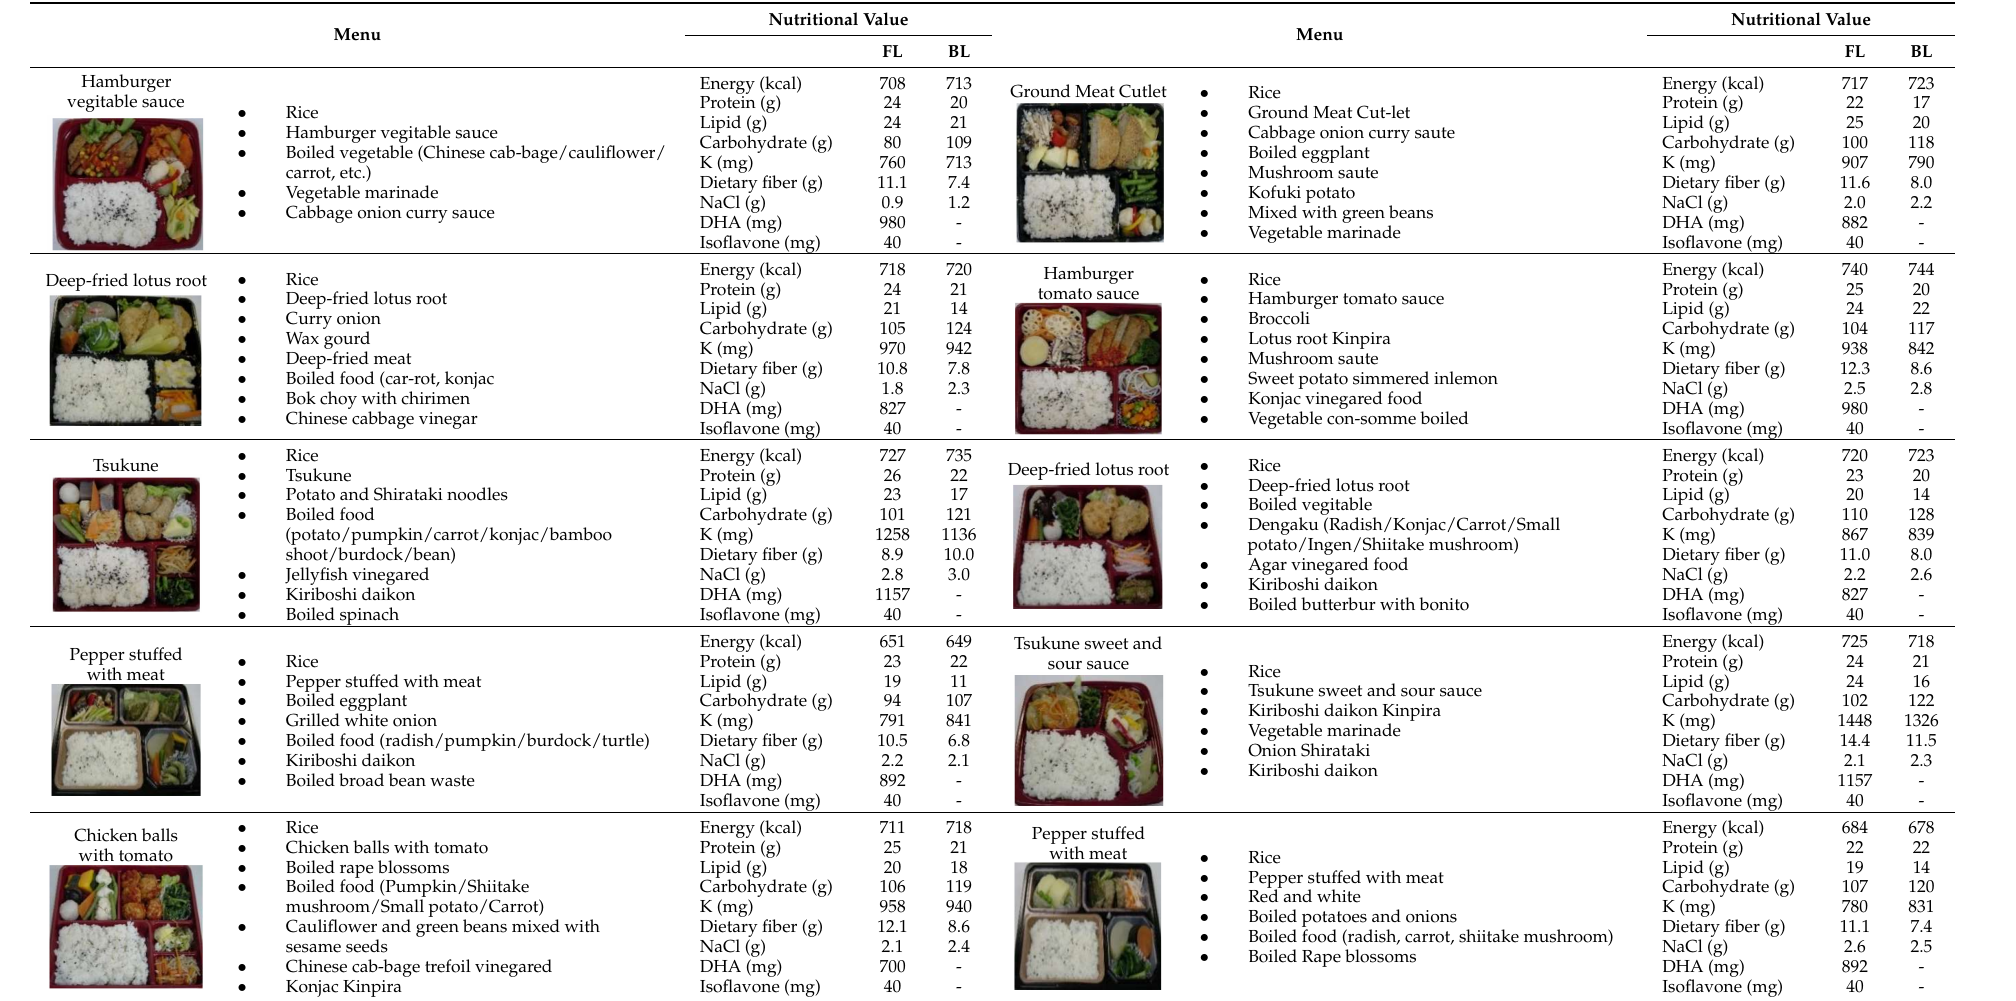
Table 2. Menu and nutritional value used in this